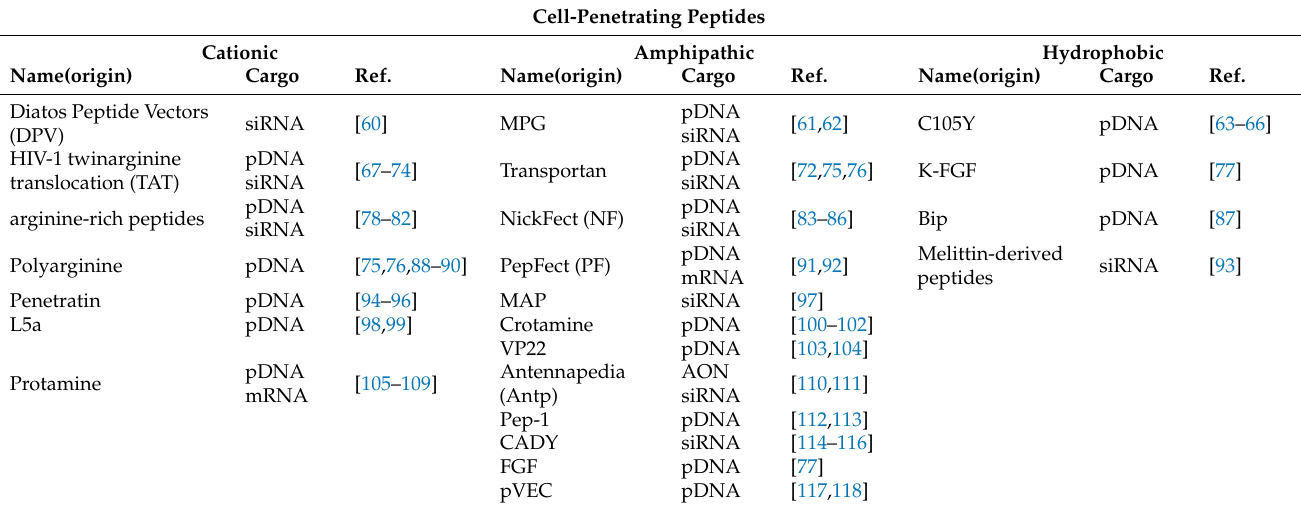
Table 2. CPP classification based on physicochemical